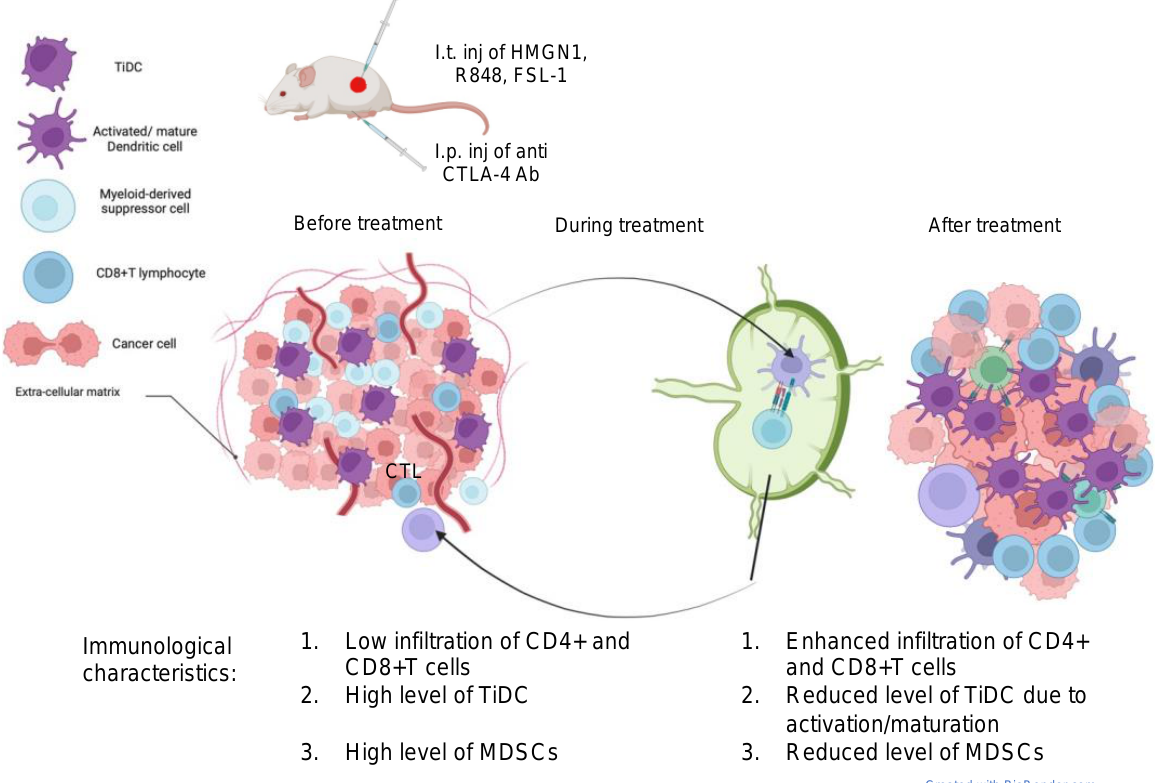
Figure 7. Schematic representation of the mechanism of action of combination therapy by HMGN1, FSL-1, anti CTLA-4 antibody, and R848.